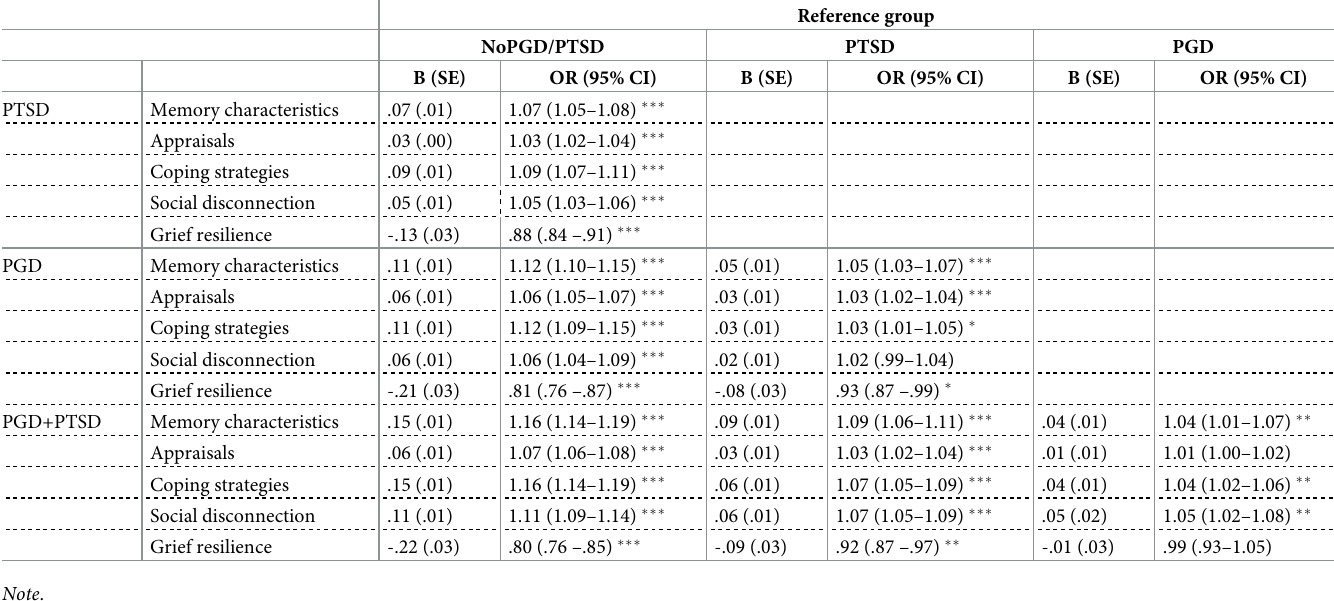
Table 3. Univariate parameter estimates of group comparisons for cognitive predictor